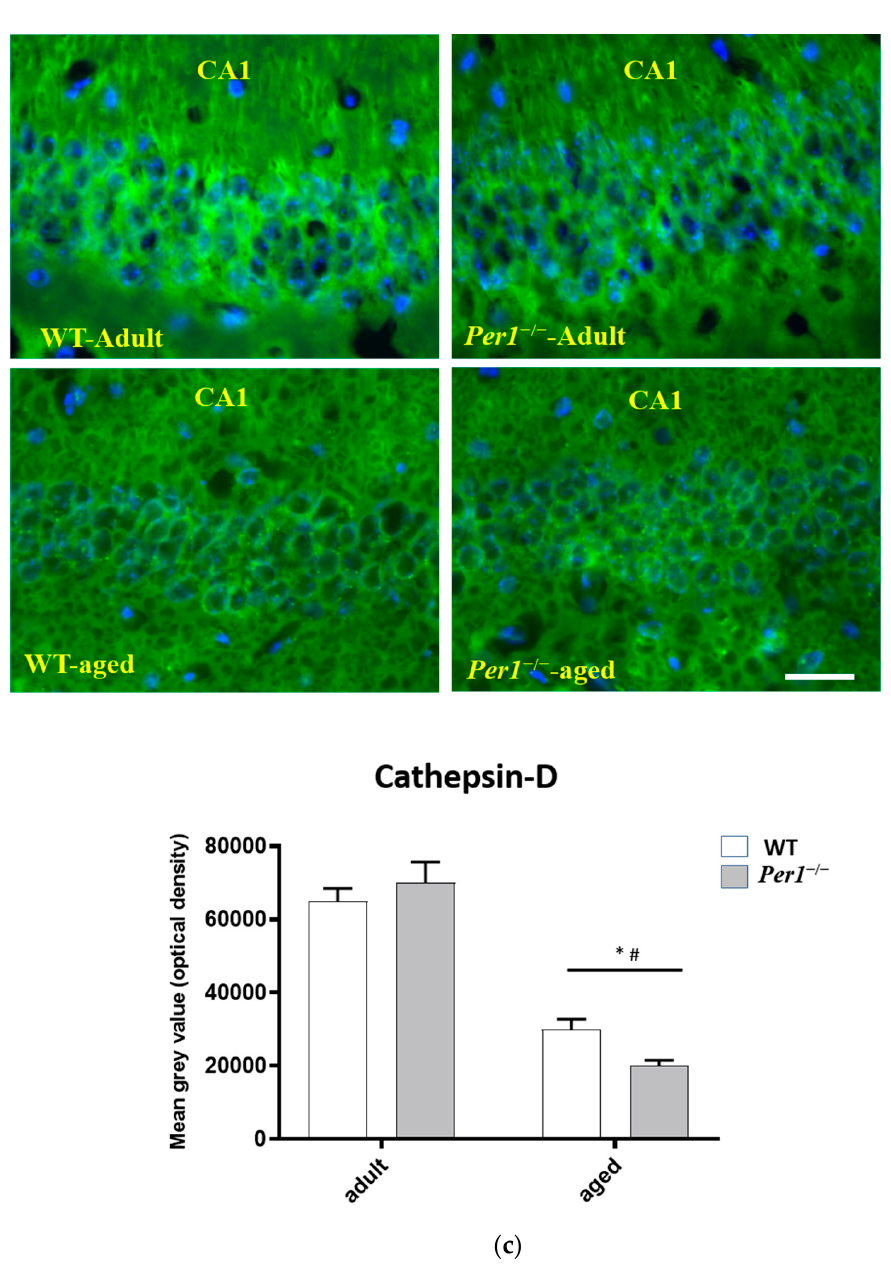
Figure 2. ( a – c ) Immunostaining and densitometric analysis of LC3A/B, LAMP1 and cathepsin-B immunoreactivities in the hippocampus of WT mice (white scale) and Per1 − / − -mice (grey scale). The LC3 immunoreactivity was decreased in both adult and aged Per1 − / − -mice. The LAMP-1 and cathepsin-B immunoreactivities were significantly reduced in aged Per1 − / − -mice. Significant differences between means were statistically assessed by ANOVA. * p < 0.05 was considered statistically significant. * difference between the age groups; # differences between genotypes. Scale bar 200 µ